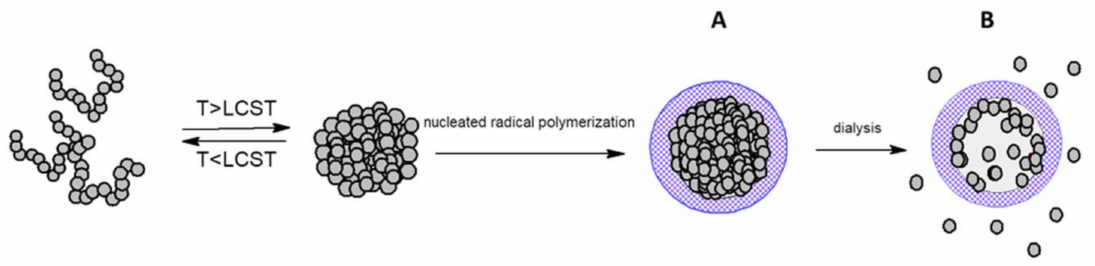
Figure 4. Nanoparticles based on mesoglobules with crosslinked shell ( A ) and hollow interior ( B